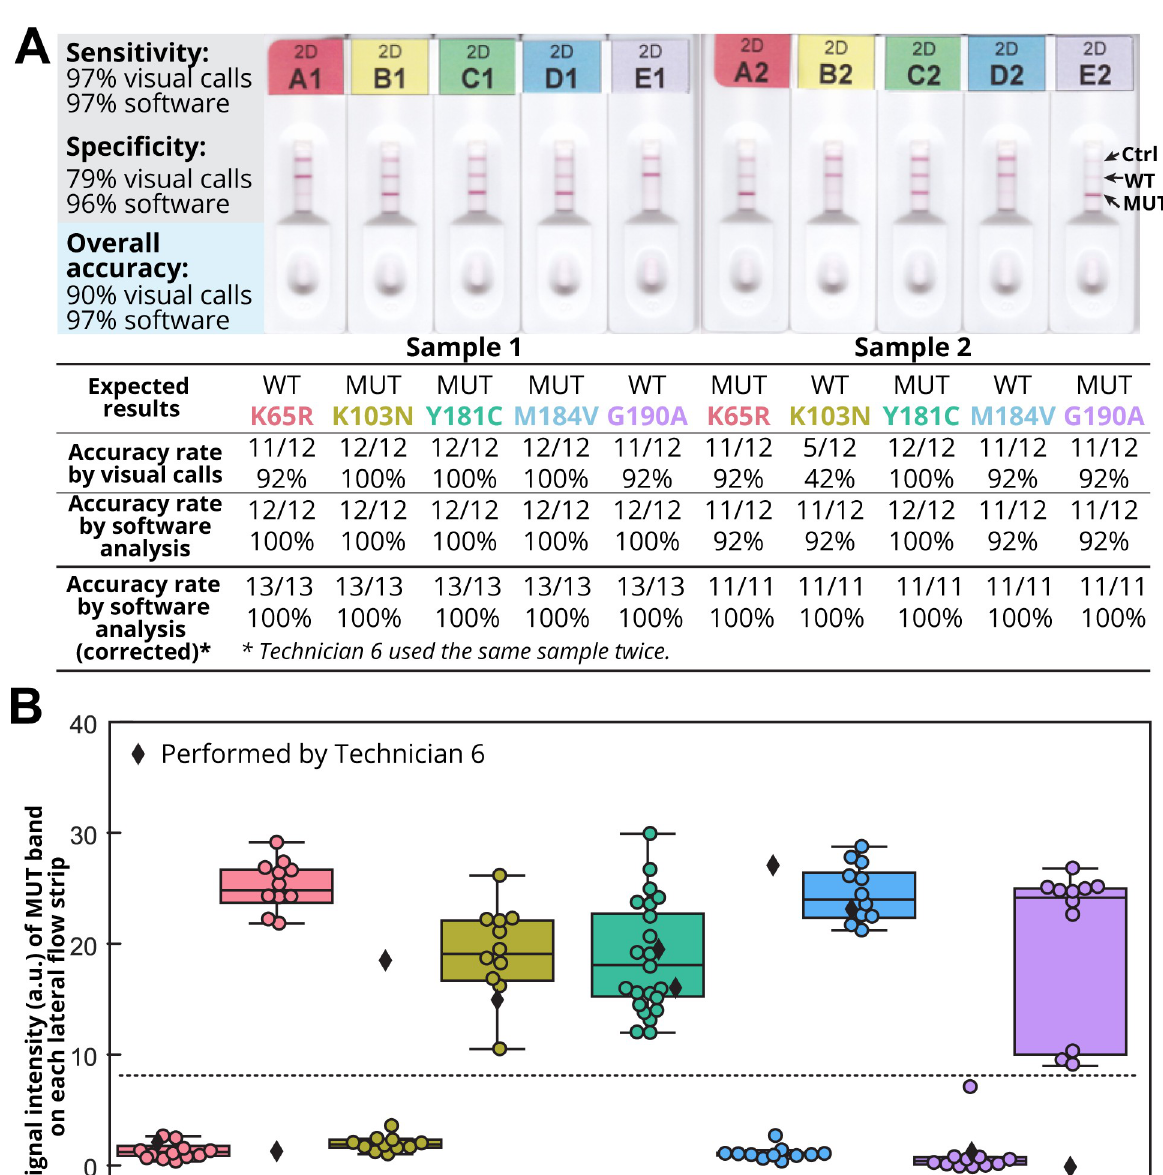
Fig 2. OLA-Simple HIVDR results and interpretations. (A) Examples of scanned images of test strips for Samples 1 and 2 and test accuracy across each codon based on visual calls made by each participant and post-processing by image analysis software. Sample1 and Sample 2 have different mutation profiles. (B) Mutant (MUT) signal intensity of each lateral flow strip. Middle lines on the box plot indicate medians. Top and bottom lines on box plot indicate interquartile ranges. Dashed lines indicate the detection threshold for MUT signal. Both Sample 1 and Sample 2 have mutant genotype at codon Y181C. Diamonds correspond to signal from the strips of a Sample 1 that was erroneously tested in place of Sample 2.